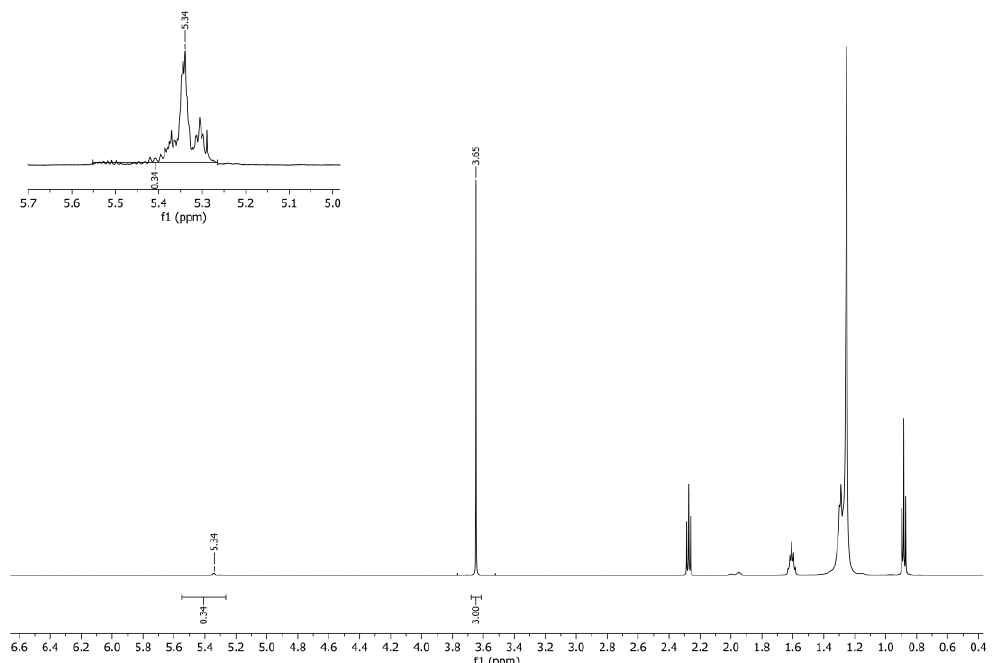
Figure 11. 1 H NMR spectrum for hydroformylated canola FAME product on the second methodol- ogy.